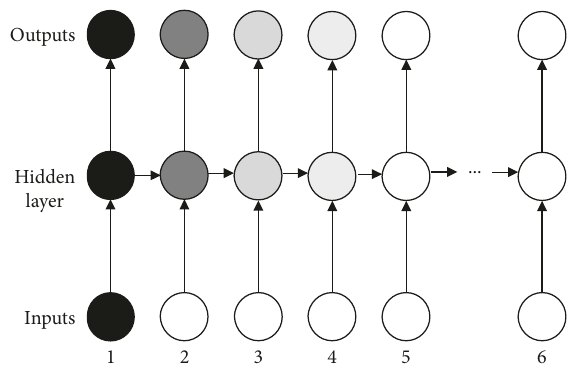
Figure 7: The vanishing gradient problem for